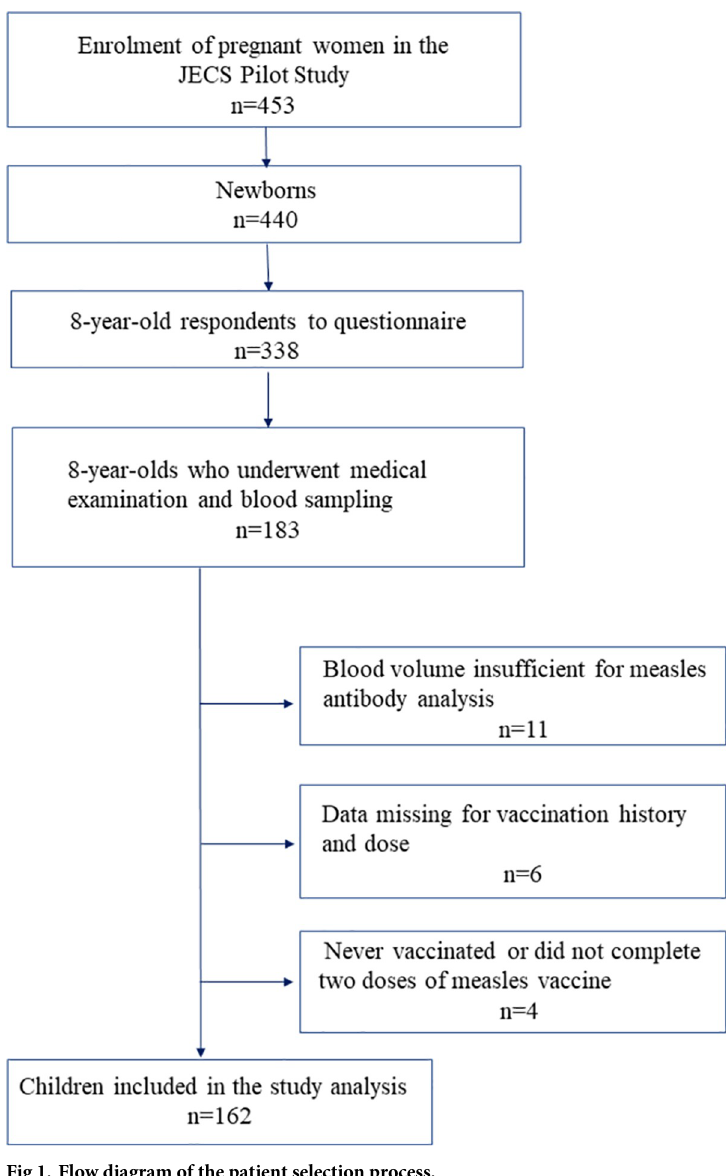
Fig 1. Flow diagram of the patient selection